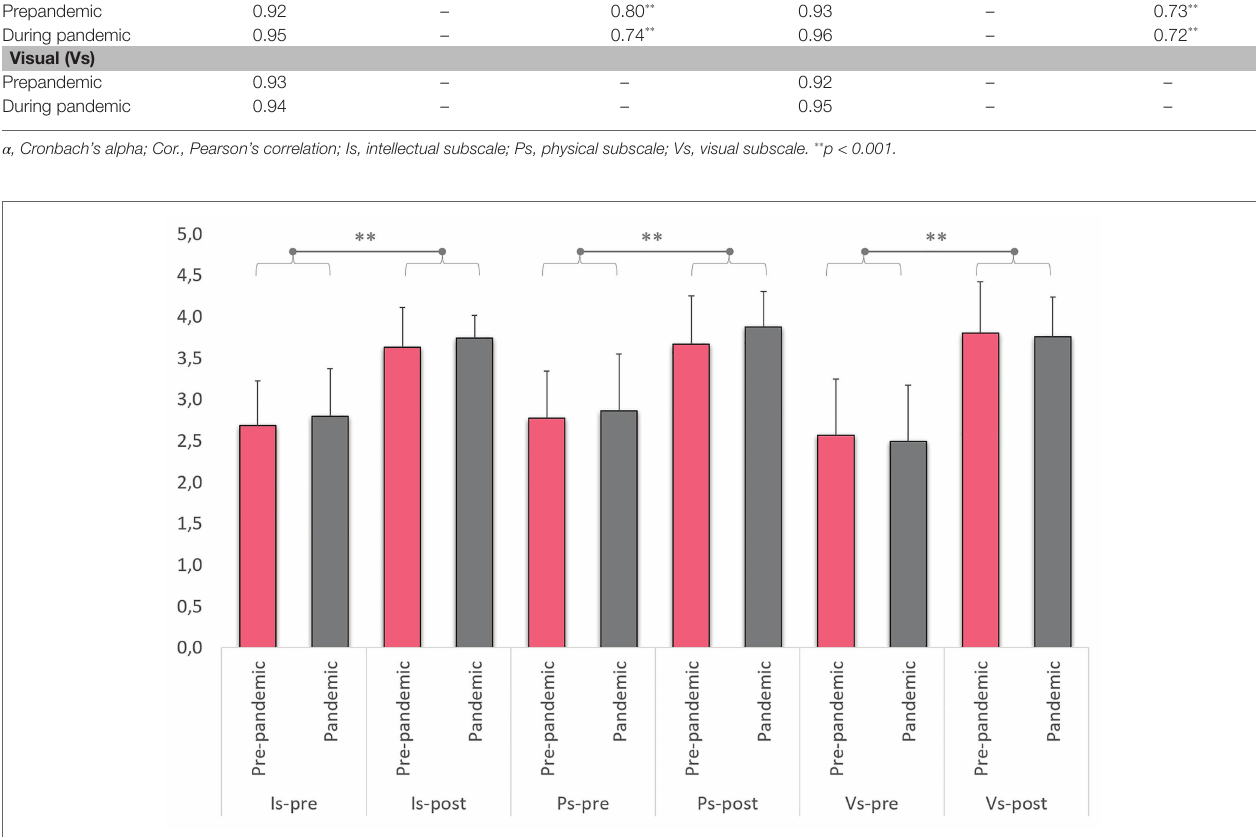
FIGURE 2 | Pre-/postcourse measurements of the three self-efficacy subscales. ** p <